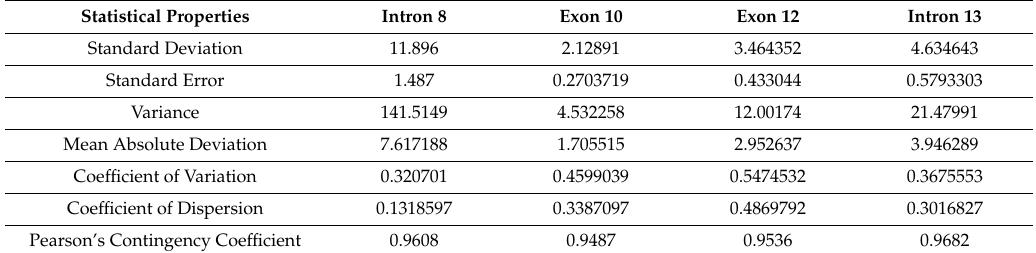
Table 4. Statistical properties of graphs Γ ( ϕ i , j ) of sequence ( ϕ i , j ) from non-cancer DNA